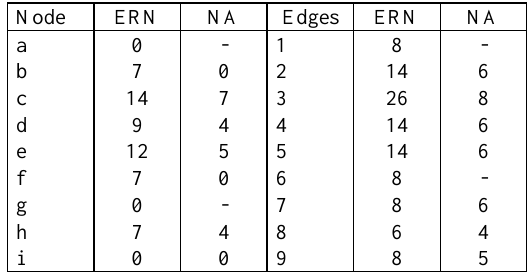
Table 1. Counts of shortest paths that passes node and edge (any distinct unordered nodes pair has one path) for entire road network (ERN) and for a neighbouring area (NA) of the illustrative road network in Figure 2.